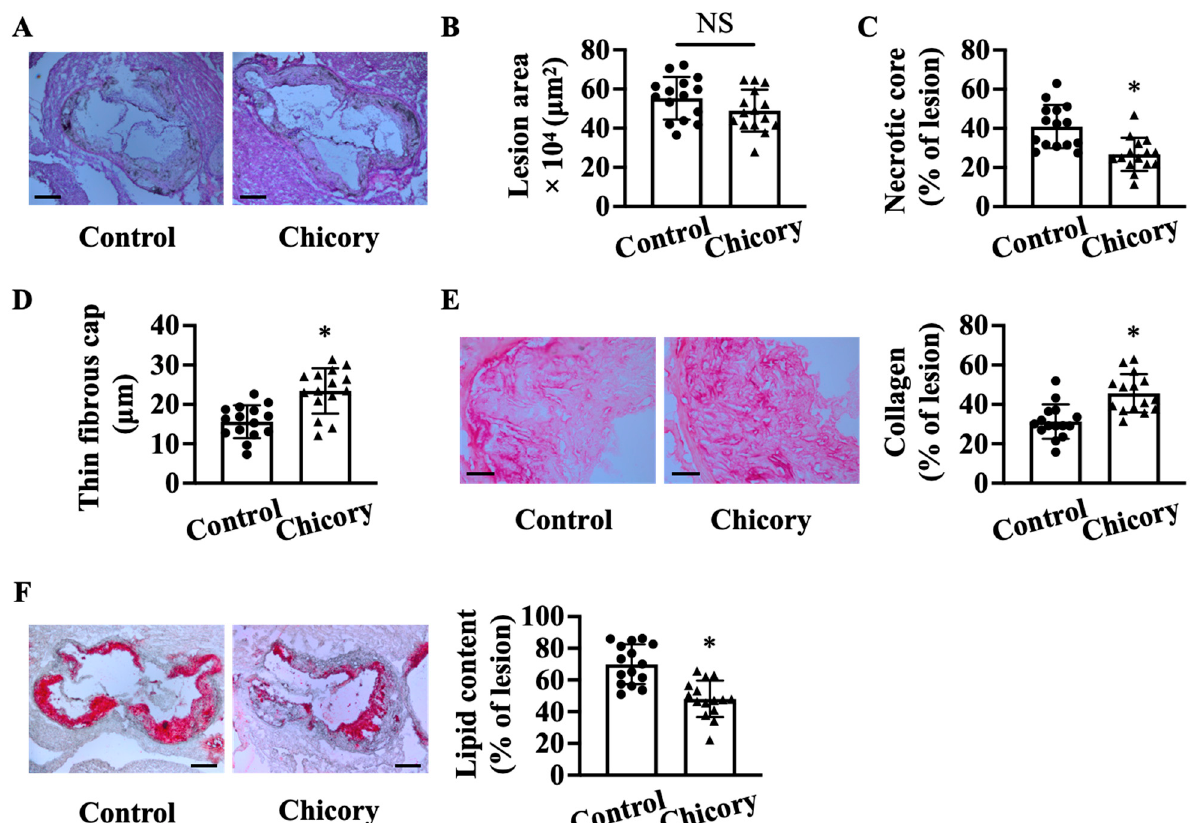
Figure 1. Brussels chicory consumption improves plaque stability without affecting plaque size in the aortic roots of Apoe − / − mice. ( A ) Representative images of hematoxylin and eosin staining. Scale bars: 250 µ m. ( B – D ): plaque size ( B ), necrotic core size ( C ), thin-fibrous cap thickness ( D ) in plaques of the aortic root. ( E ) Representative images of Sirius red staining (left panel) and quantification (right panel) of collagen accumulation in plaques. Scale bars: 50 µ m. ( F ) Representative images of oil red O staining (left panel) and quantification (right panel) of the neutral lipid content in plaques. Scale bars: 250 µ m. Data are presented as means ± SD. n = 15. * Significantly different from the control group ( p < 0.05). Apoe, apolipoprotein E; Chicory, Brussels chicory; NS, nonsignificant ( p ≥